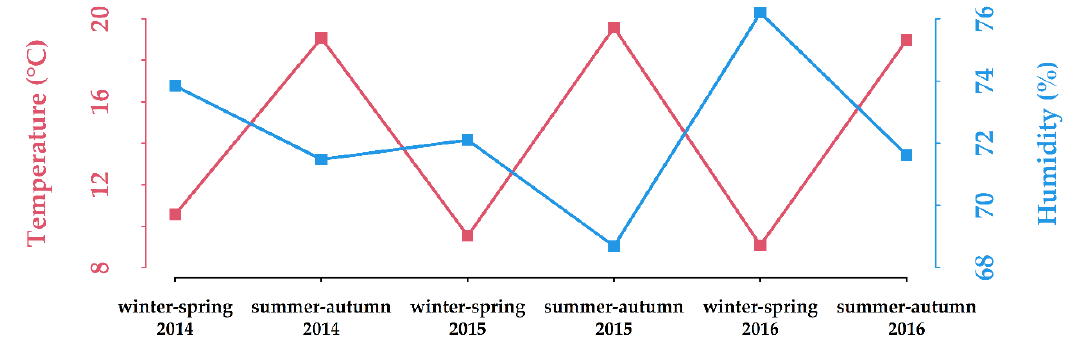
Figure 1. Seasonal means of temperatures and relative humidity recorded in Verona (Villafranca monitoring station, VILSPA; www.ilmeteo.it/portale/archivio-meteo/Verona) through the study period. Winter-spring: 1 December to 31 May; summer-autumn: 1 June to 30 November.